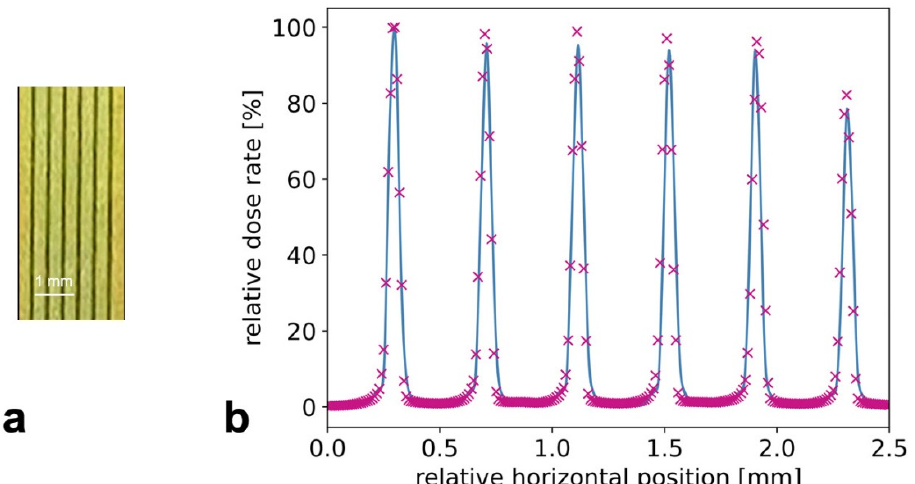
Figure 6. Microbeams obtained at the beamline P61A. Recorded on an HD-V2 Gafchromic™ film ( a ) and relative dose rate measured with the X-Tream (blue) and PTW microDiamond (magenta) ( b ).